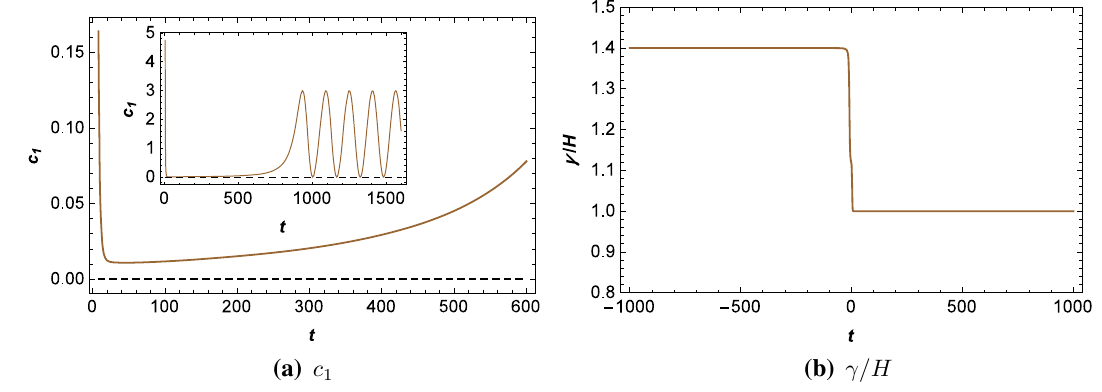
Fig. 3 The evolution of c 1 , γ/ H and (cid:6) , while we set f 1 = 5, f 2 = − 0 . 23, f 3 = − 13 f 2 , q 1 = 1, q 2 = 0 . 2, q 3 = 0 . 2, q 4 = 2, λ = 4 × 10 − 4 , φ = 7, φ = 22 . 7 and φ = 5 . 0 1 2